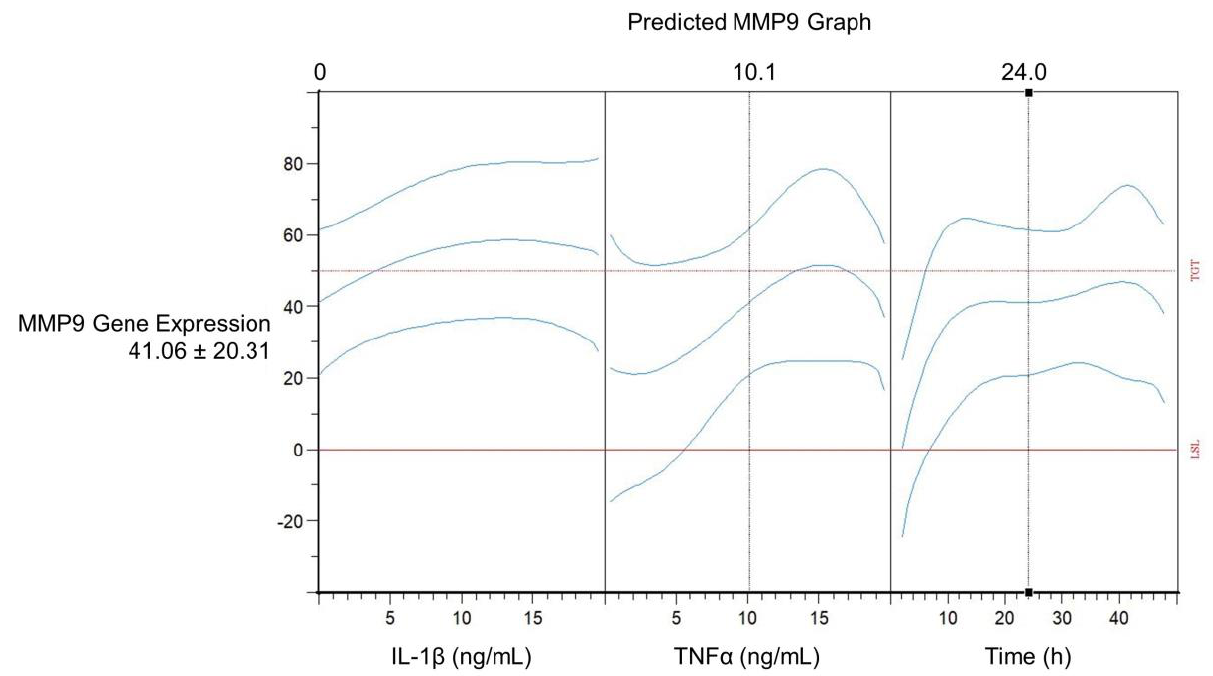
Figure 6. Predicted response graph in Cornerstone: IL-1 β concentration (ng/mL), TNF α concentra-